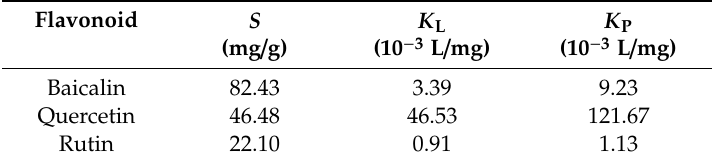
Table 3. Parameters for the Langmuir–Nernst isotherm of flavonoids adsorption. Flavonoid